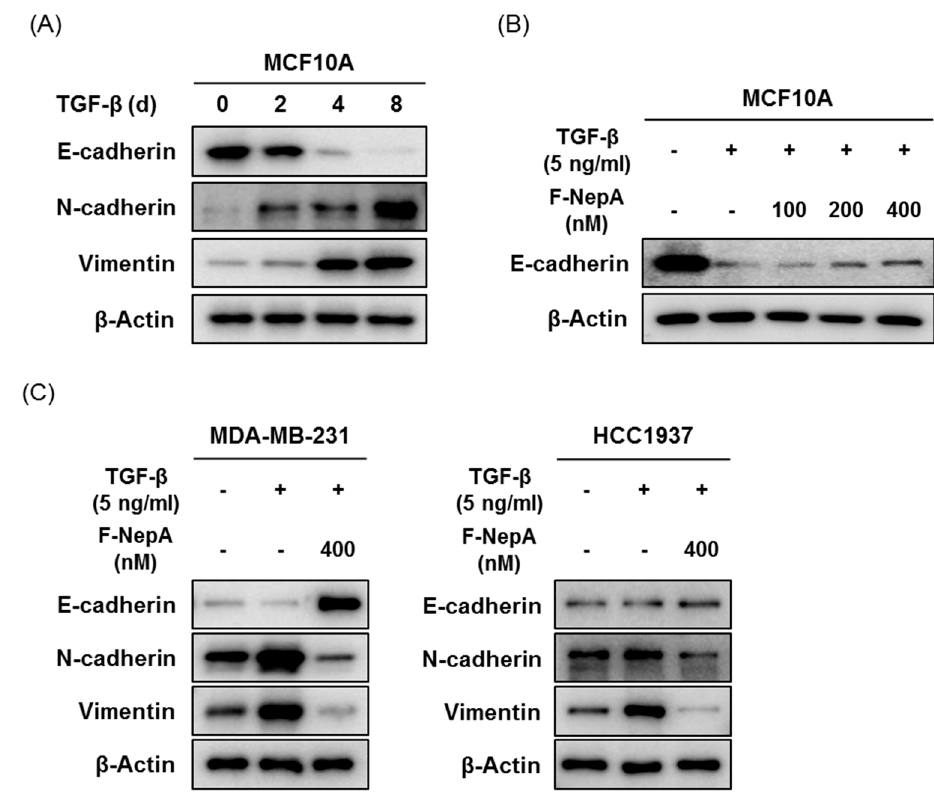
Figure 6. F-NepA reverses TGF- β induced EMT biomarker expressions. ( A ) MCF10A cells were treated with TGF- β 1 (5 ng/mL) for indicated time periods, and the protein expression of E-cadherin, N-cadherin, and Vimentin was analyzed by Western blotting. β -Actin was used as an internal control. ( B ) MCF10A cells were treated in the presence or absence of TGF- β 1 (5 ng/mL) for 8 days, and then fresh media without TGF- β 1 were replaced and treated with indicated concentrations of F-NepA for an additional 2 days. The expression of E-cadherin was analyzed by Western blotting. β -Actin was used as an internal control. ( C ) MDA-MB-231 and HCC1937 cells were treated in the presence or absence of TGF- β 1 (5 ng/mL) for 8 days, and then fresh media were replaced without TGF- β 1 and treated with indicated concentrations of F-NepA for an additional 2 days. The expression of E-cadherin, N-cadherin, and Vimentin was analyzed by Western blotting. β -Actin was used as an internal control.